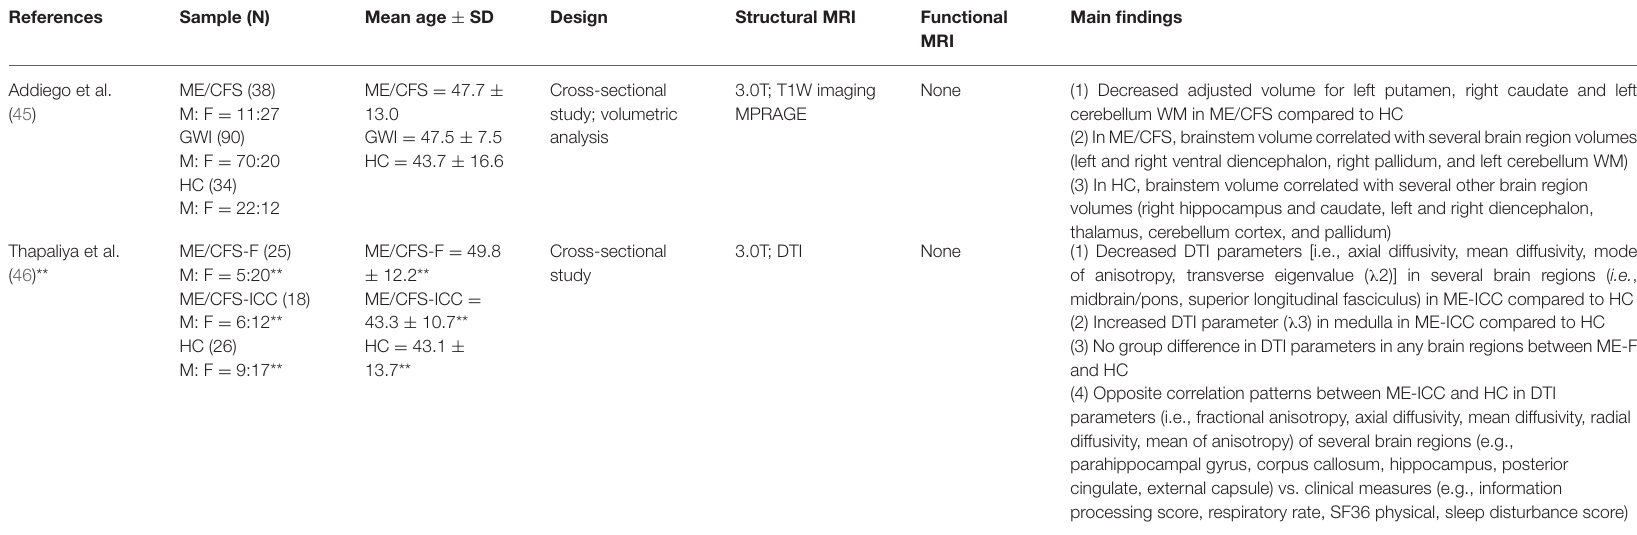
Thapaliya et al. (1) Decreased DTI parameters [i.e., axial diffusivity, mean diffusivity, mode * Indicating same cohort and data is available in another Table entry (1). ** Indicating that these entries mostly applied the same cohort as Table entry (8). M: F, males: females; MRI, magnetic resonance imaging; SD, standard deviation; ME/CFS, myalgic encephalomyelitis/chronic fatigue syndrome; M, male; F, female; HC, healthy control; T1W, T1-weighted; T2W, T2-weighted; GRE, gradient echo; GM, gray matter; WM, white matter; PP, pulse pressure; BP, blood pressure; HR, heart rate; MPRAGE, magnetization prepared rapid gradient echo; TIV, total intracranial volume; fMRI, functional magnetic resonance imaging; ASL, arterial spin labeling; PASAT, Paced Auditory Serial Addition Test; FC, functional connectivity; SPACE, Sampling Perfection with Application optimized Contrast; EPI, echo-planar imaging; T2-FLAIR, T2-weighted Fluid-Attenuated Inversion Recovery; GWI, Gulf War Illness; ME/CFS-F, ME/CFS Fukada criteria; ME/CFS-ICC, ME/CFS International Consensus